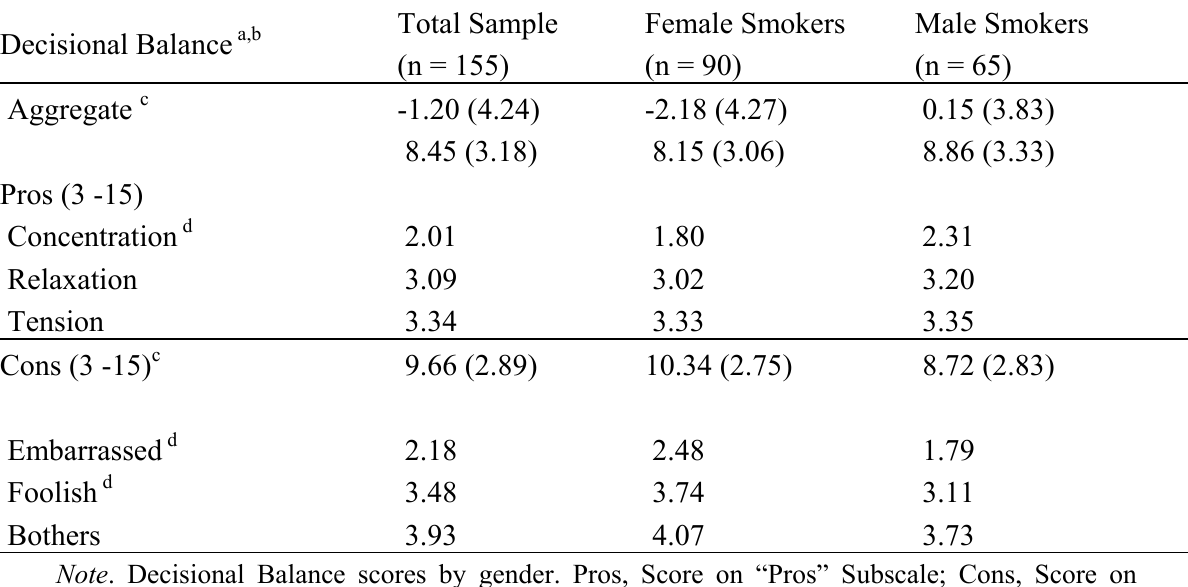
Table 2. Mean Decisional Balance, Pros and Cons Subscale Scores by